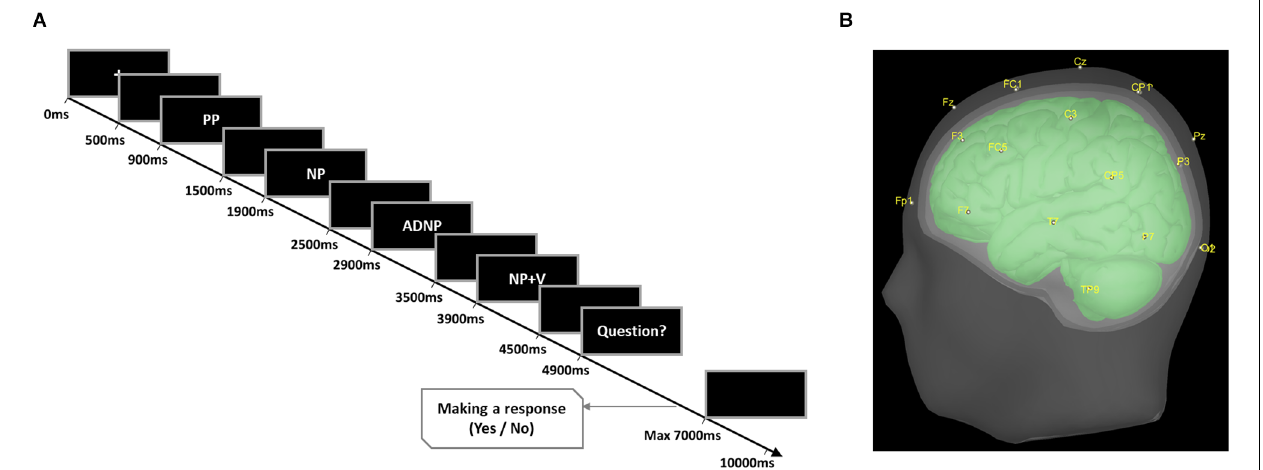
FIGURE 1 | Language-related ERP experiment design. (A) Rapid Serial Visual Presentation paradigm. The figure shows the experimental design in which the experimental sentences are divided into four blocks and sequentially presented as visual stimuli, with the plausibility judgment task being performed at the end of the sentence. (B) Head model and EEG electrode placement. The figure shows the three-layer boundary element method head model reconstructed from the MNI ICBM 152 brain template, and the sensor locations on the